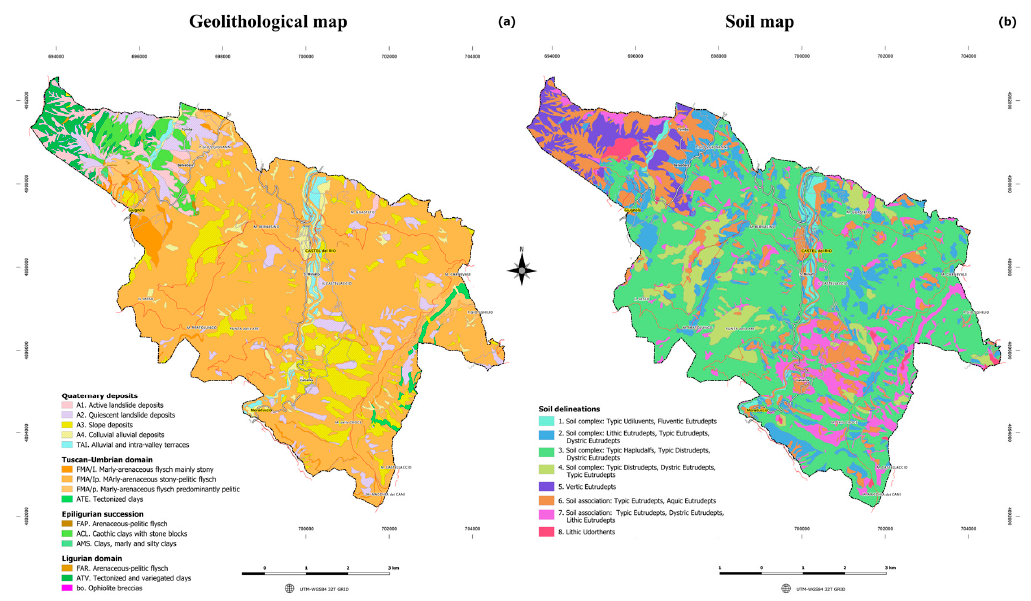
Figure 2. Geolithological ( a ) and soil ( b ) maps of Castel del Rio, Emilia-Romagna Region, Italy. To build the suitability map for CSFP, the areas were considered suitable if located within the Castanetum phytoclimatic zone [42], namely at an altitude ranging between 300 and 1000 m above sea level [43–46] with north-facing exposition, from northwest to northeast [45,46] (Table 2). In this context, it is important to mention that the considered thresholds for altitude and exposure can be used for the northern part of the Apennine Mountain Range in Italy because of having the best climatic (air temperature and rainfalls) conditions for chestnut plants [46]. Regarding the slope gradient, it was considered suitable if it was less than 20°, allowing for the easy management of groves, including chestnut nut harvesting [47] and preventing intense soil erosion processes [48]. In terms of lithology, carbonate ‐ free rocks as soil parent material (i.e., rhyolite, trachyte, pyroclastic deposits, siliceous rocks, sandstones, and greenschists) were considered. Such lithologies were selected on the basis of the most frequent lithological types found under chestnut grove cultivation in Italy [49] (Table A1 of Appendix A). Table 2. Restriction rates for Castanea sativa Mill. cultivation for fruit production related to altitude, exposure, slope gradient, and lithology. Geomorphological Characters